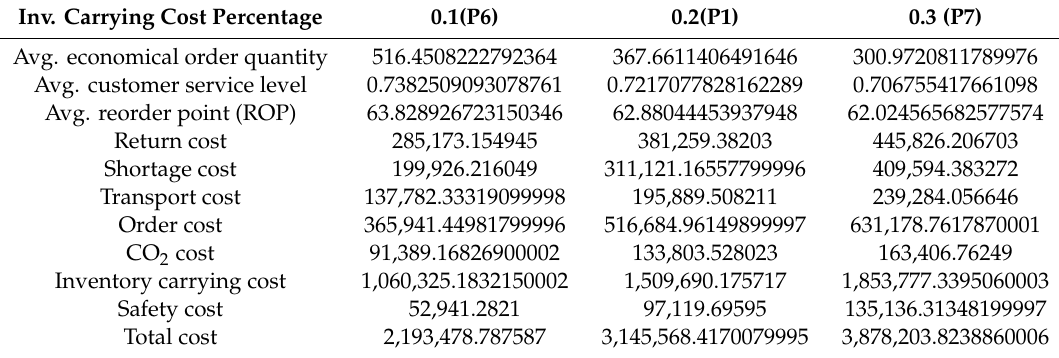
Table 16. The results of the sensitivity analysis for inventory carrying cost percentage based on ROPIRPSDRCO 2 . Inv. Carrying Cost Percentage 0.1(P6) 0.2(P1) 0.3 (P7) Avg. economical order